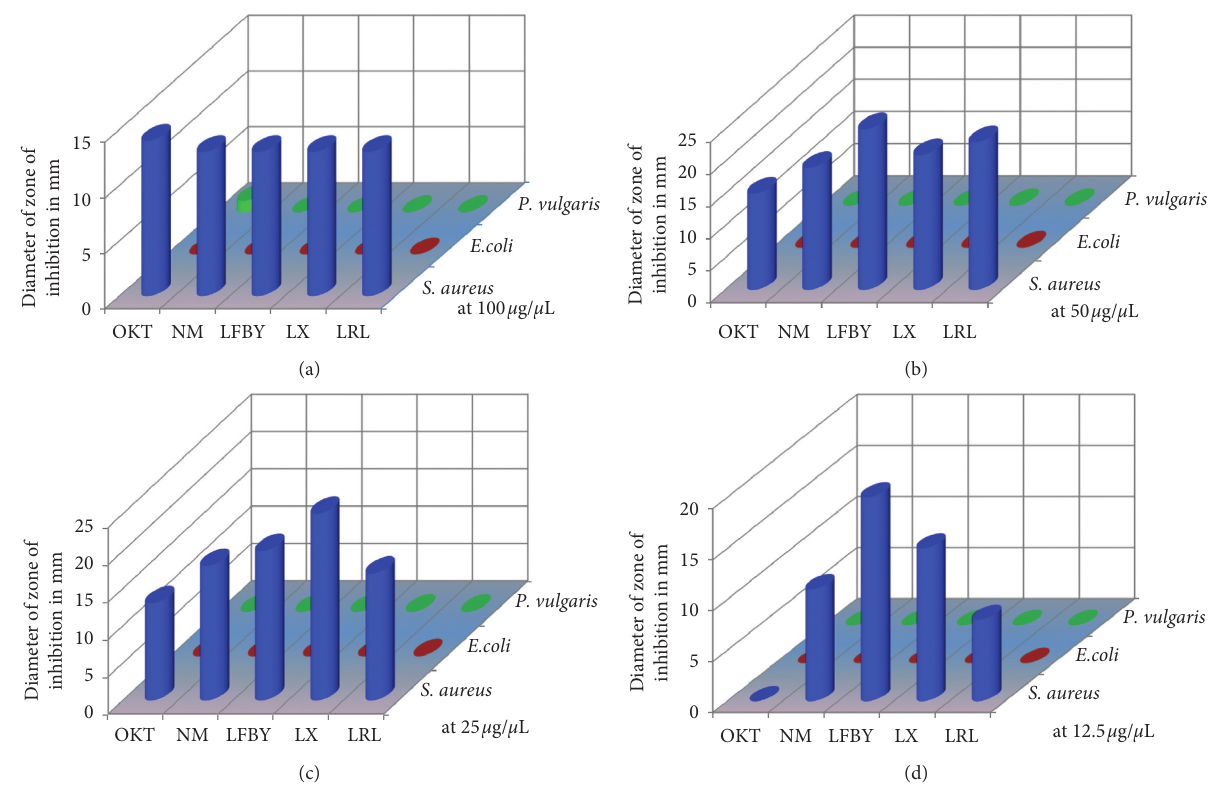
Figure 19: The antibacterial action of the soaps against the pathogenic bacteria at four different Table 5, and the results are evaluated on bar graph (Fig-